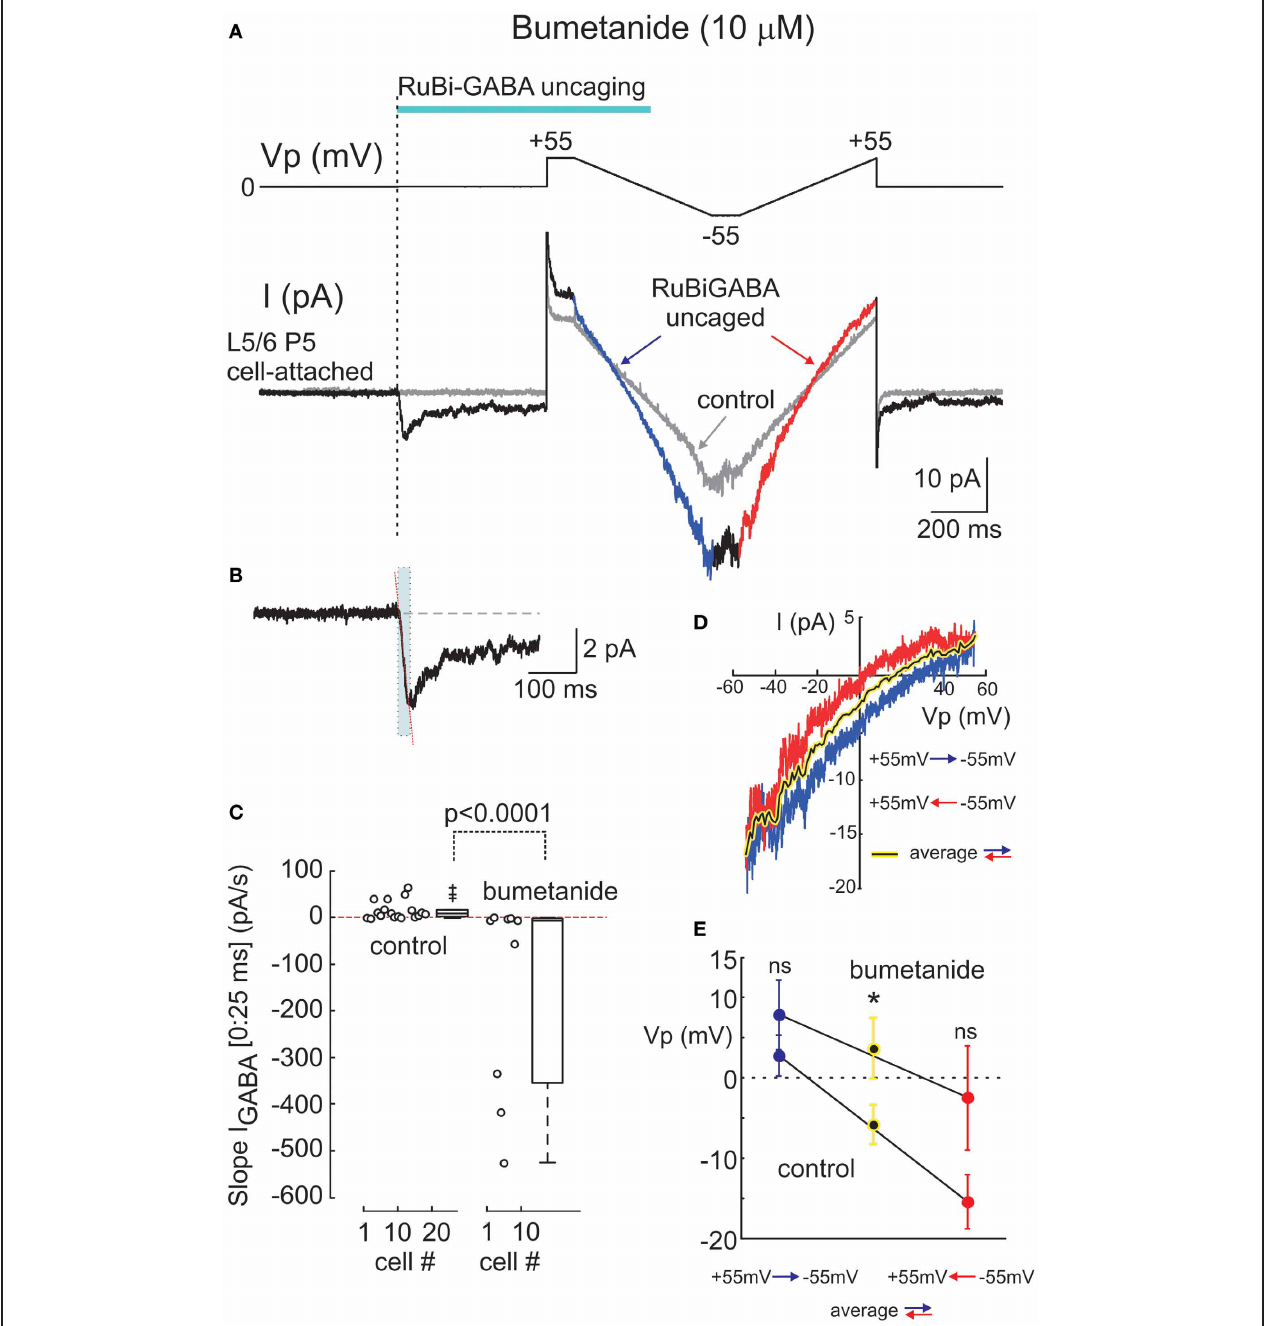
the initial slopes change direction from inward to outward after the addition of bumetanide. (D) Current-voltage relationships of the uncaged GABA-activated cell-attached currents during bidirectional ramp voltage commands (layout is same as in Figure 1C ). (E) Summary plot of the reversal potentials of the uncaged GABA activated currents using the ramp protocol. Blue and red circles (mean ± S.E.) correspond to the hyperpolarizing-to-depolarizing and depolarizing-to-hyperpolarizing ramp directions, respectively. Black on yellow circles correspond to the bidirectional ramp averages. (C–E) Pooled data from 16 neurons in control conditions and 9 neurons in the presence of bumetanide (P2-5 rats; ∗ p < 0 . 05; ns,